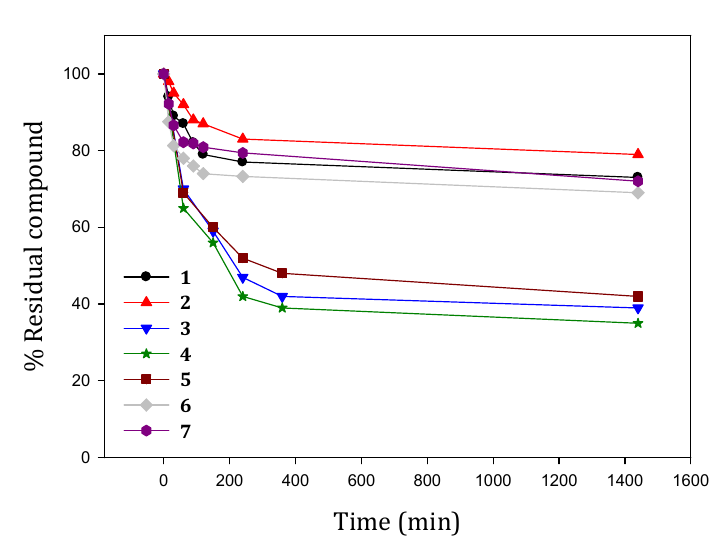
Figure 2. Stability profiles of the curcumin derivatives in simulated physiological conditions (PBS, 0.01 M; NaCl, 0.1 M; pH = 7.4; 37 ◦ C in darkness). Residual percentage was calculated as A t × 100/A 0 , where A t and A 0 stand for absorbance at λ max at time t and time zero,